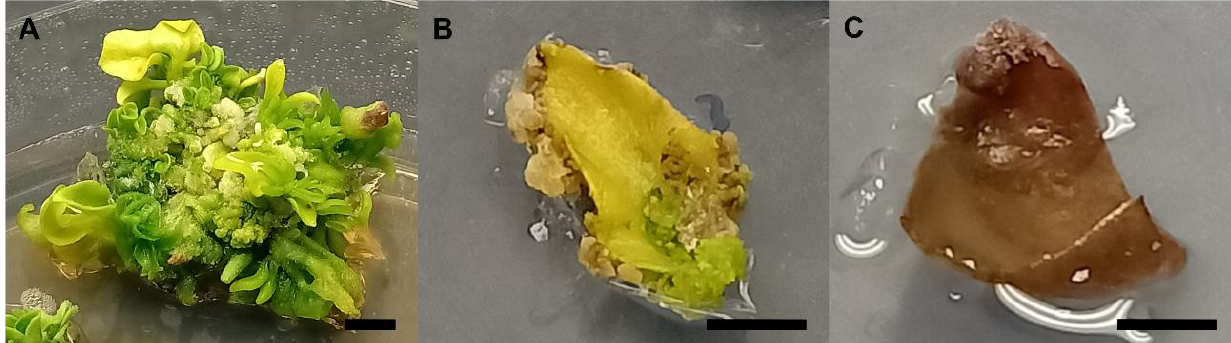
Figure 2. Scoring tissue status (scale from 1 to 3) for Capsicum explants. ( A ) green tissue (1); ( B ) dull greyish brown tissue (2); ( C ) dead tissue (3). In each of the subfigures, the bar for reference measures 0.5 cm.